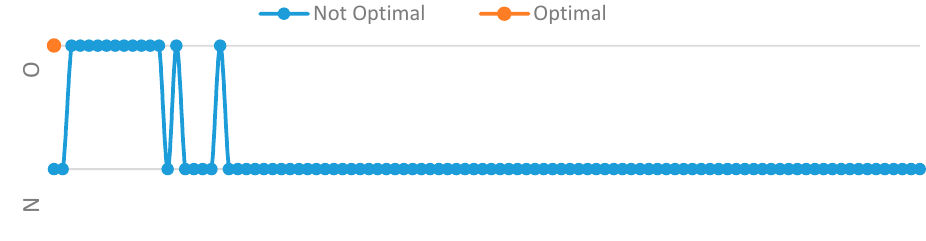
Figure 5. Determination of optimal alternatives.